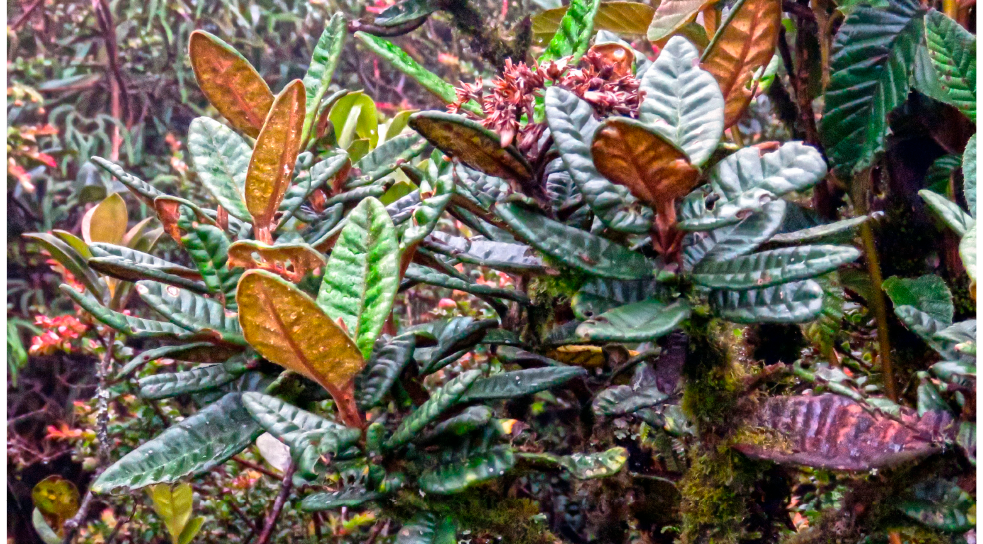
Figure 1. G. rugulosa shrub at the collection site (photo by G. Gilardoni).